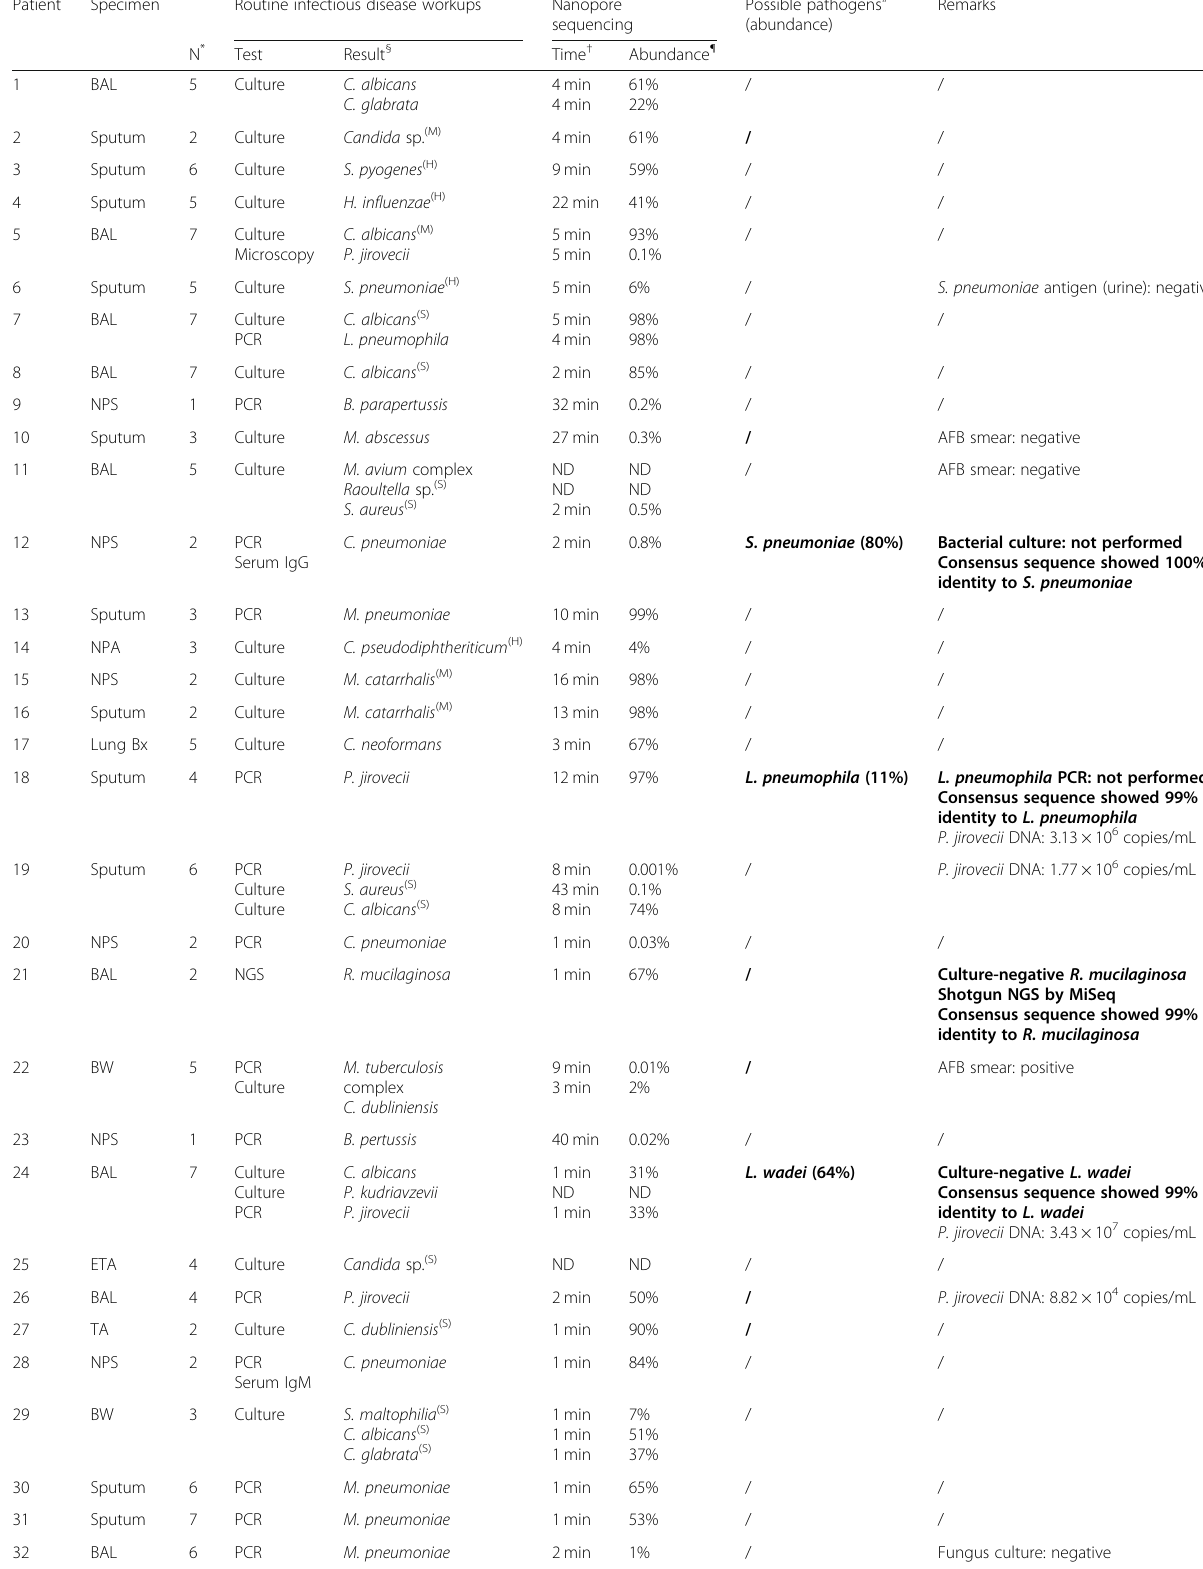
Table 1 Details of clinical specimens and results of Nanopore sequencing